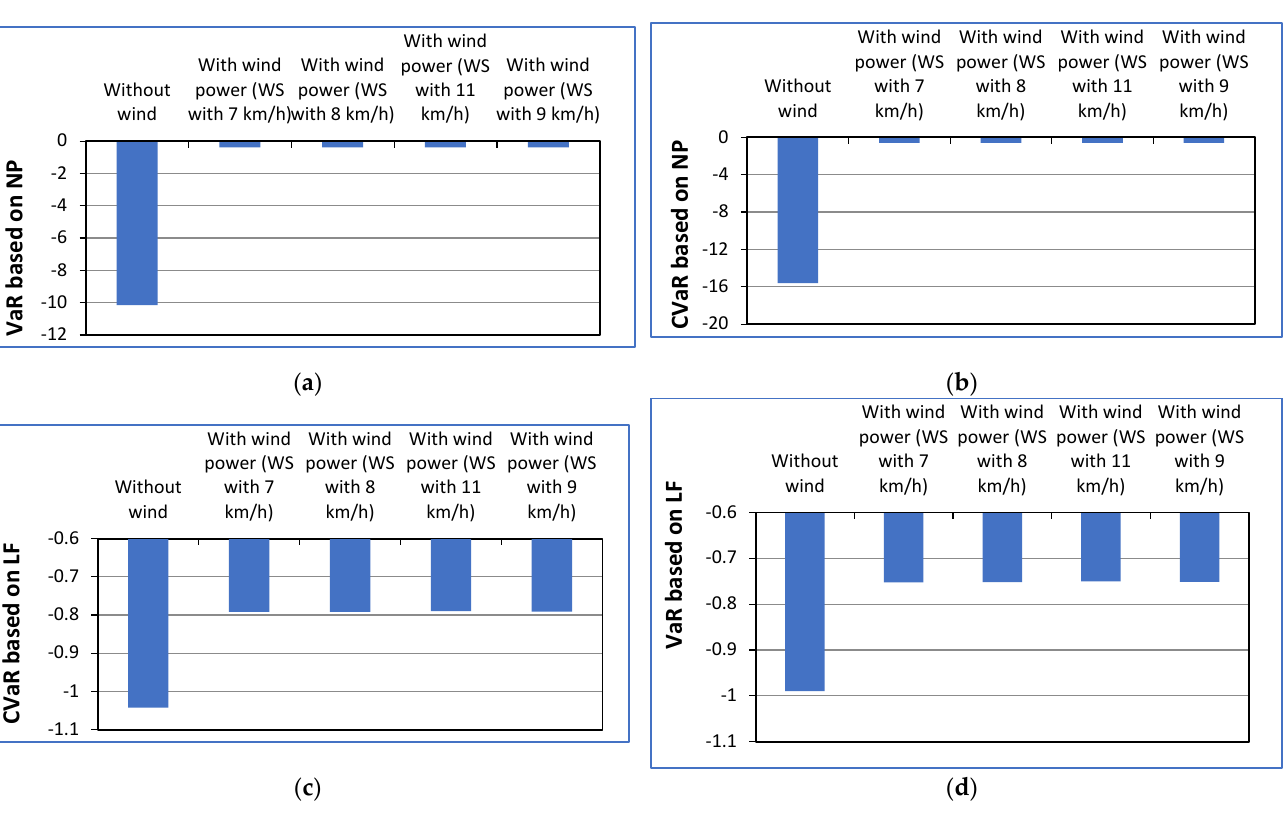
Figure 7. System Risk with Wind Power Integration (Mumbai @ Bus_10 (15%)). VaR based on NP ( a ), CvaR basd on NP ( b ), VaR based on LF ( c ), CvaR based on LF ( d ).